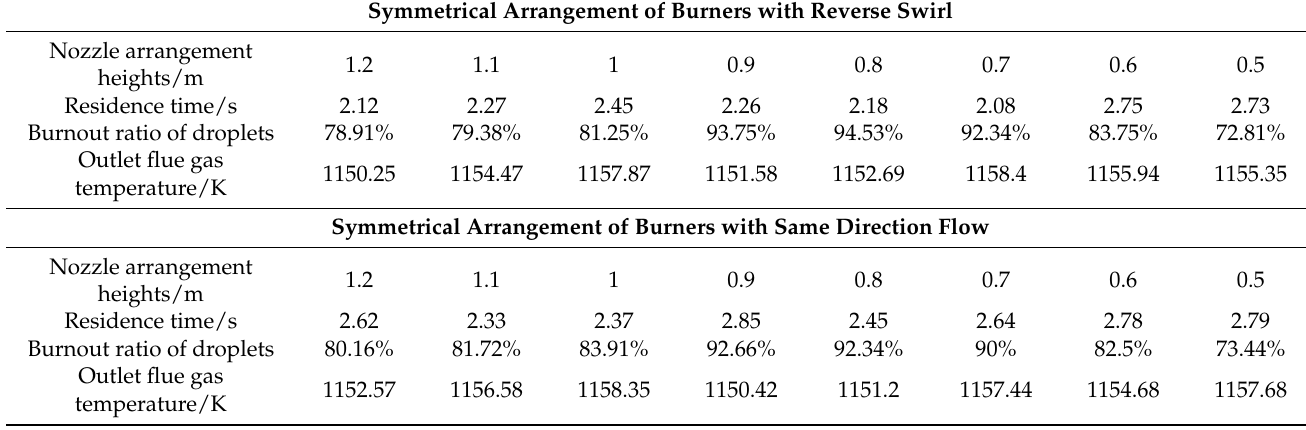
Table 3. The residence time of the flue gas, the burnout ratio of droplets and the outlet flue gas temperature under different nozzle arrangement heights.